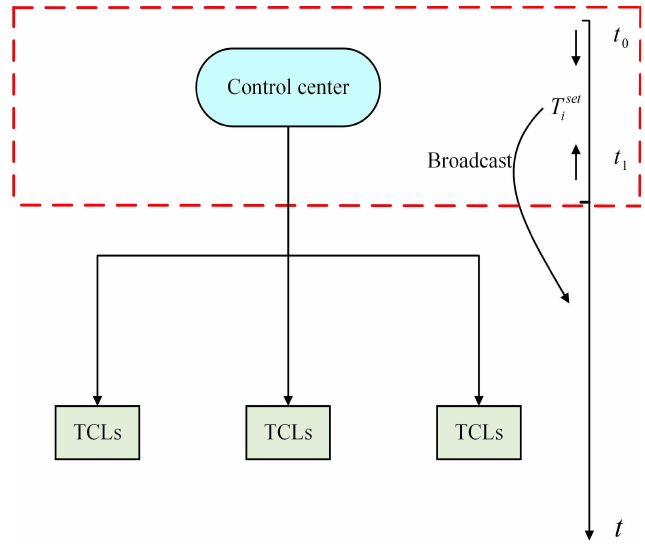
Figure 4. Optimized control